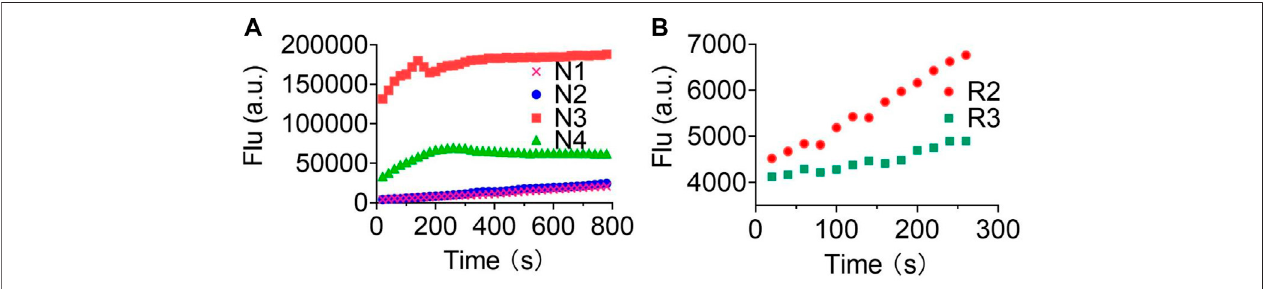
(cid:129) − (cid:129) − probes: N1 , N2 , N3 , and N4 . (B) , redox-based O 2